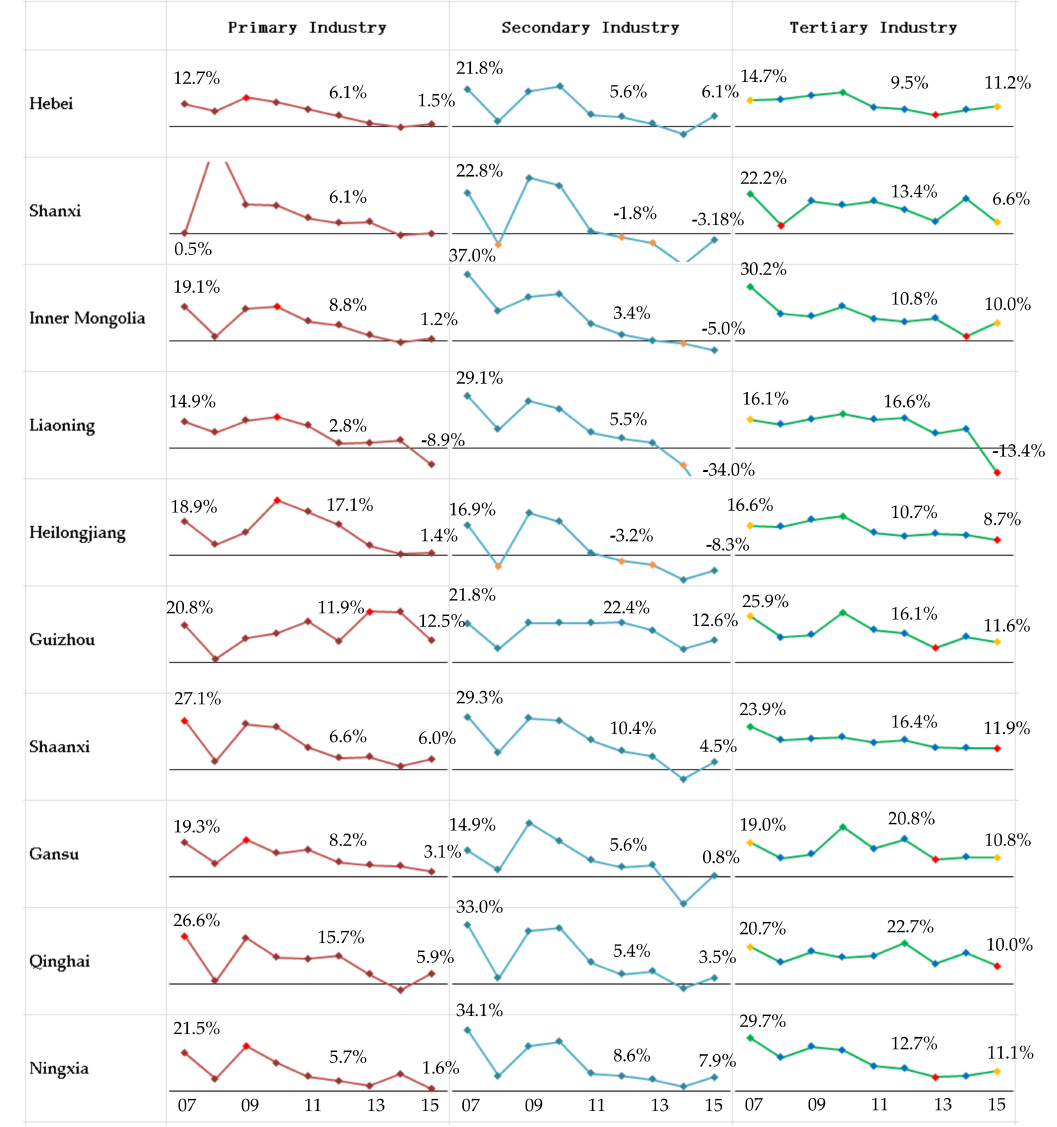
Figure 2. The annual growth rate of the three industries in regions of Group